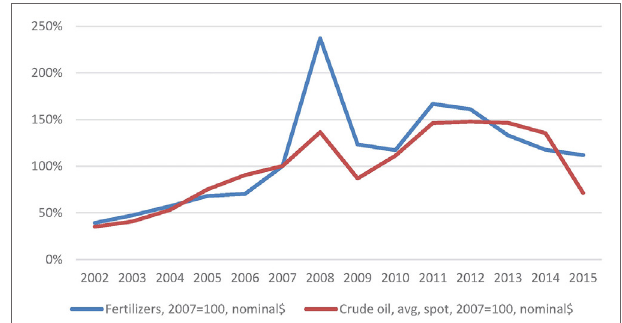
FigUre 3 | Global fertilizer and oil prices in percent relative to 2007. Data from database: Global Economic Monitor (GEM) Commodities, World